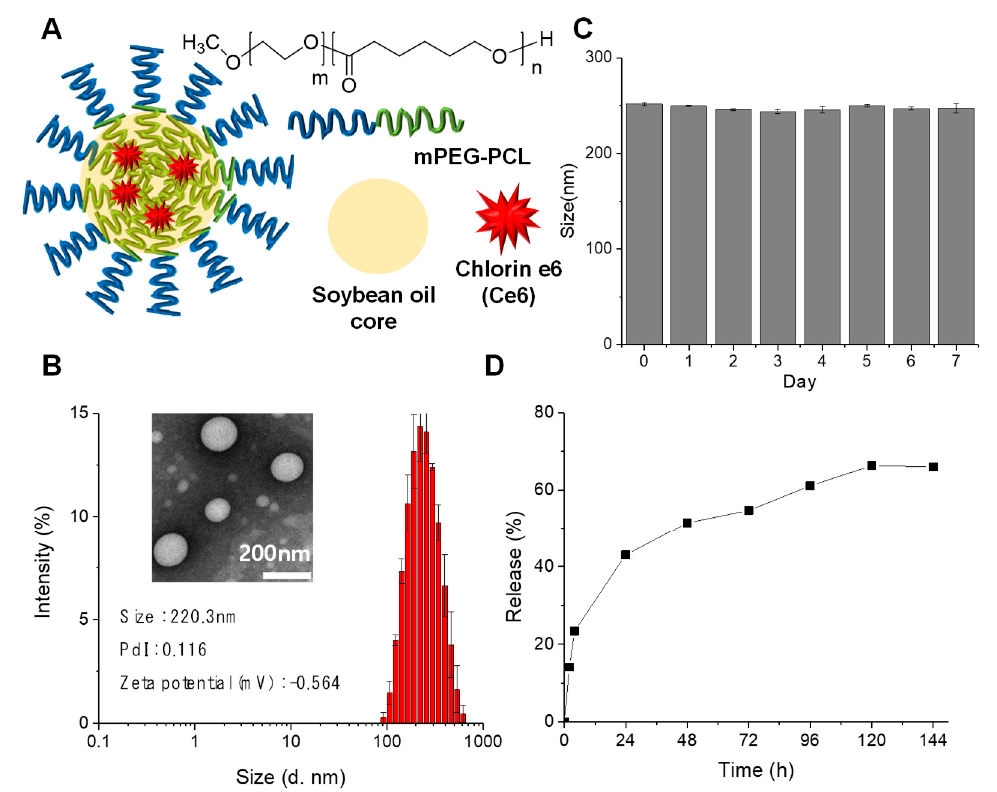
Figure 1. Synthesis and characterization of Ce6-PCL-NE. ( A ) Schematic illustration of Ce6-PCL-NE. ( B ) Size distribution and TEM image of Ce6-PCL-NEs. ( C ) Size change of Ce6-PCL-NEs in PBS (pH 7.4) during one week. ( D ) Release profile of Ce6 from Ce6-PCL-NE for 6 days.